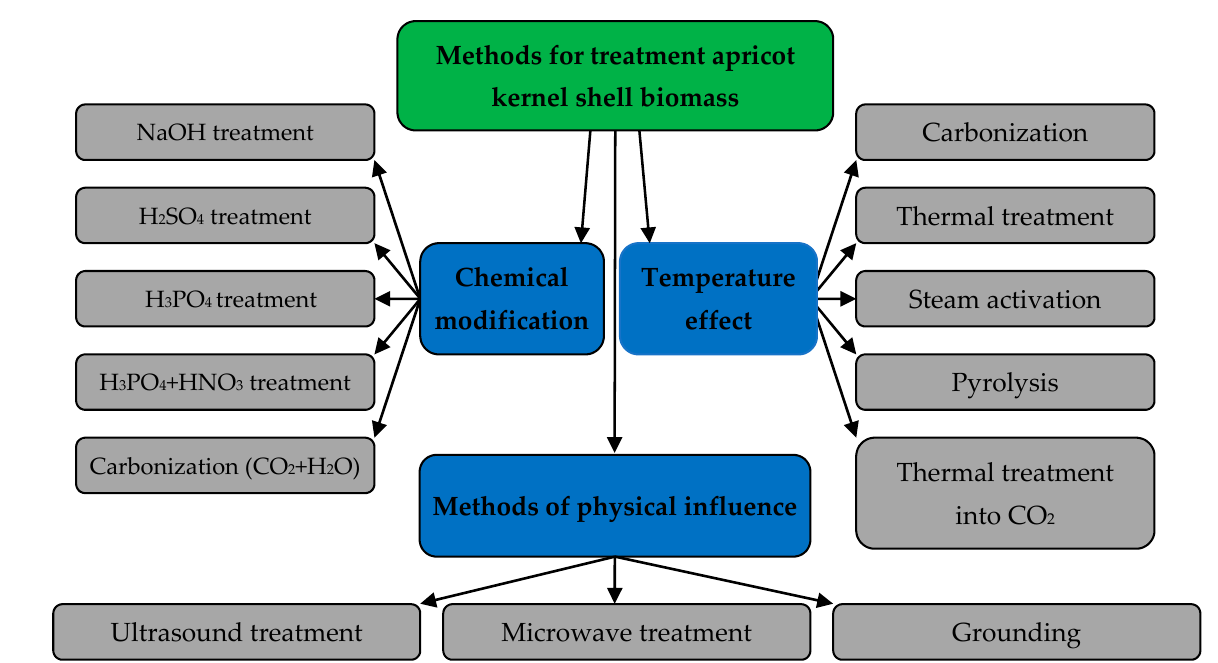
Figure 3. Methods used for the treatment of apricot kernel shell biomass.